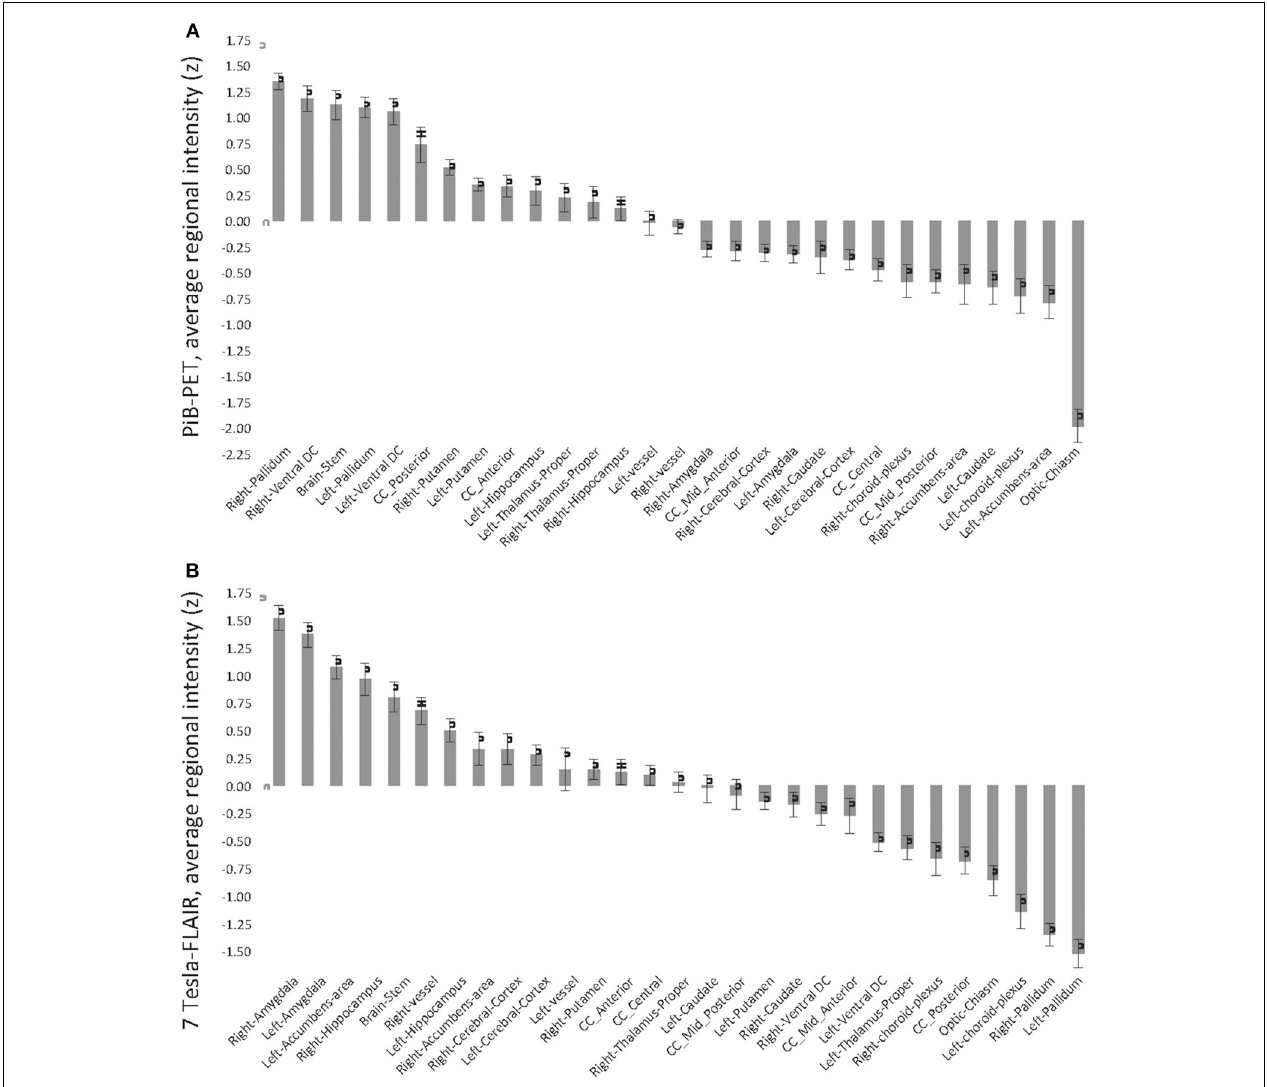
FIGURE 2 | Standardized z-scores of regional average intensities, normalized by T1-volume, sorted in descending order. (A) Pittsburgh Compund-B positron emission tomography; (B) Fluid-attenuated inversion recovery (FLAIR) 7 Tesla MRI